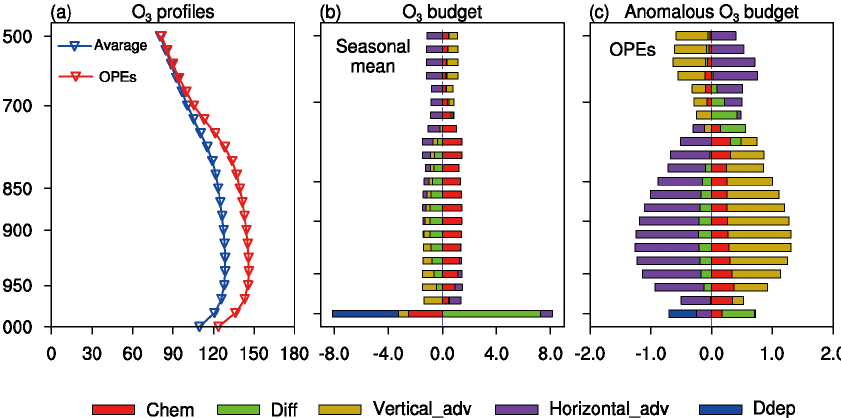
n n n P P P O i · 100%, where O i and S i indicate the (S i − O i )/ (S i − O i ) and NMB = n i i i